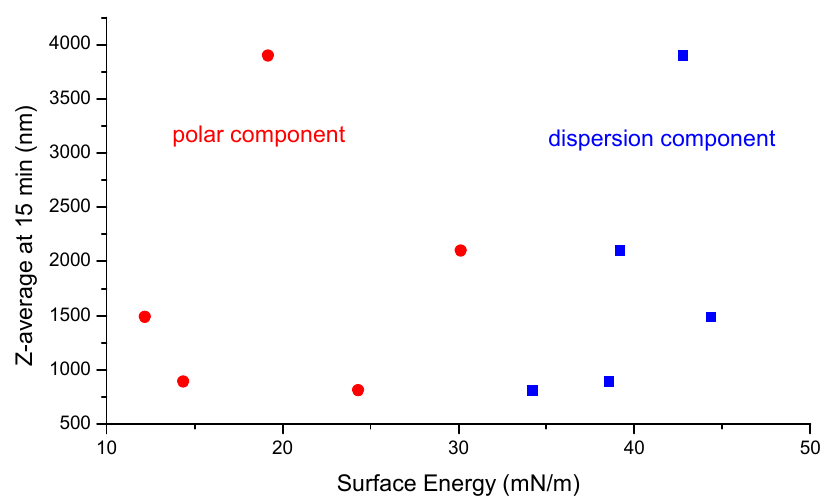
Figure 2. Correlation between Z-average size of IBU at 15 min of milling with the individual surface energy components of the stabilizers.